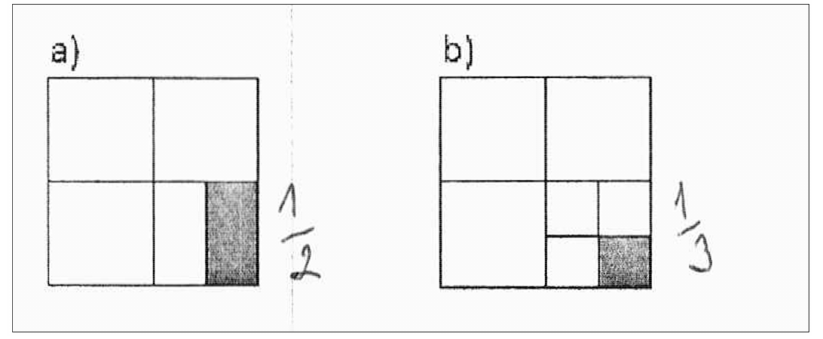
Figure 8. Incorrect solution 2.